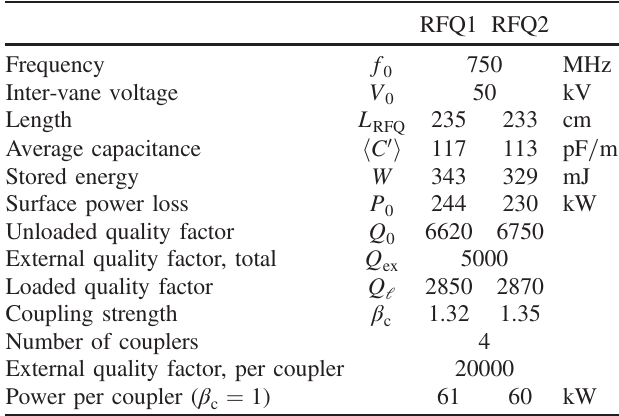
on the tips of tuner (a), t